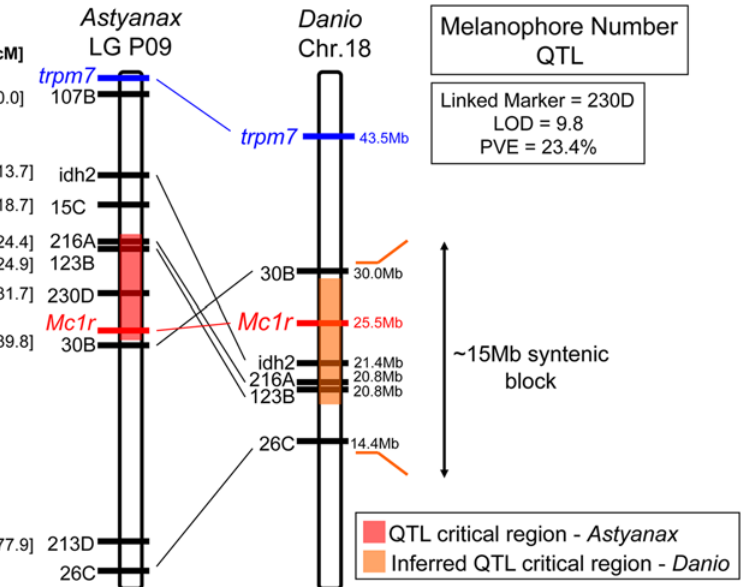
Figure 2. Astyanax linkage group P09 anchors strongly to Danio chromosome 18. Genomic sequences flanking microsatellites on Astyanax linkage group P09 are localized to within a , 15 Mb stretch of Danio chromosome (Chr.) 18. Two candidate genes, Mc1r and trpm7 , are present on chromosome 18 in Danio , however only Mc1r co-localizes to the critical region (red rectangle) of the melanophore number QTL on Astyanax linkage group P09. Legend: QTL critical region on Astyanax linkage group P09 (red rectangle), inferred QTL critical region on Danio chromosome 18 (orange triangle).